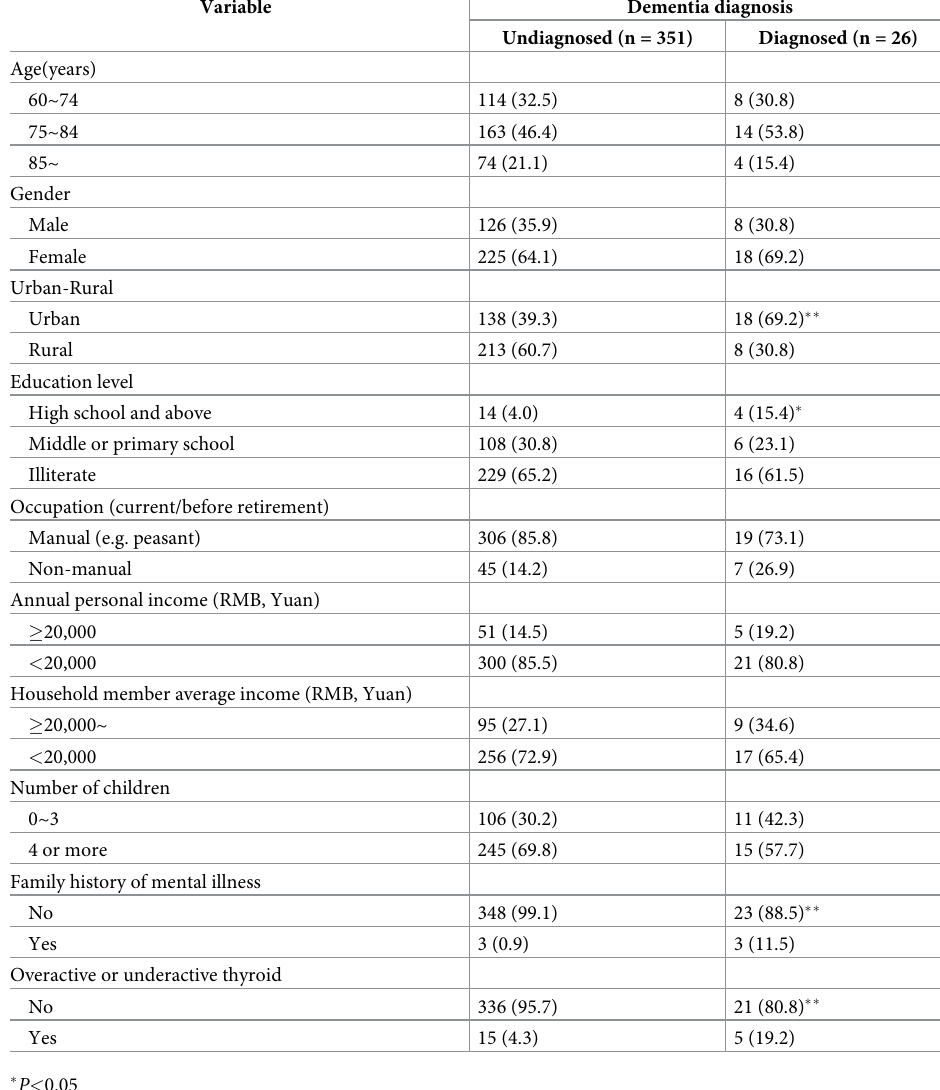
Table 2. Demograhic characteristics of the dementia patients from the six-province study. Variable Dementia diagnosis Undiagnosed (n = 351) Diagnosed (n =